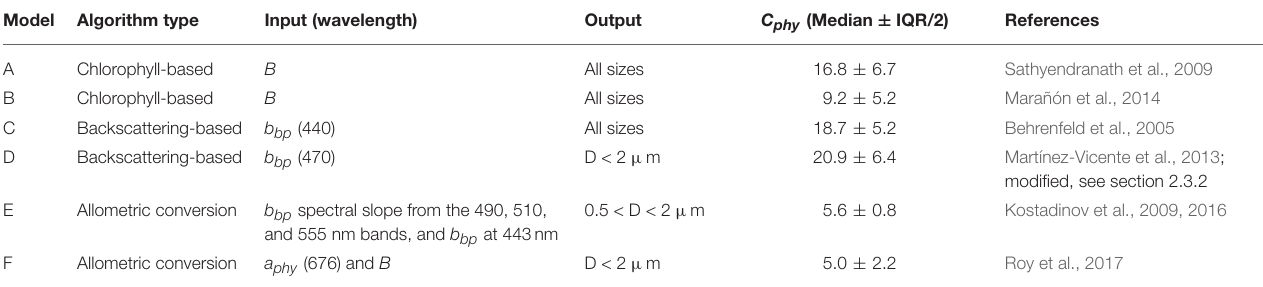
TABLE 2 | Summary of C phy algorithms main characteristics and median values predicted for the in situ match-up database ( N = 557). Model Algorithm